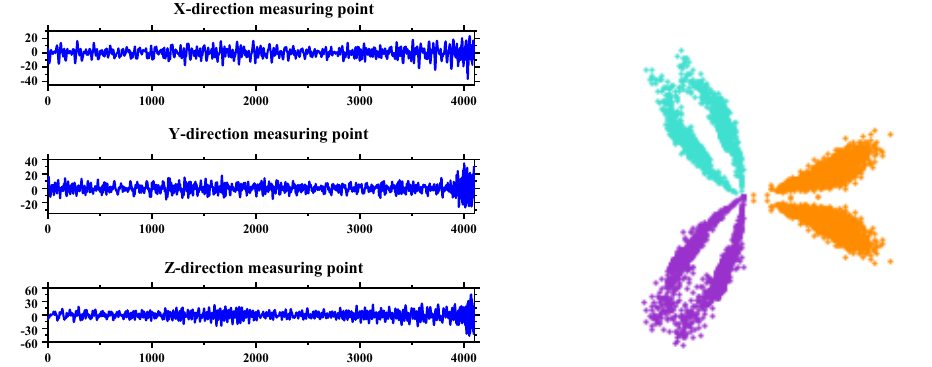
Figure 14. Transformation from multiple-channel signals to SDP image.